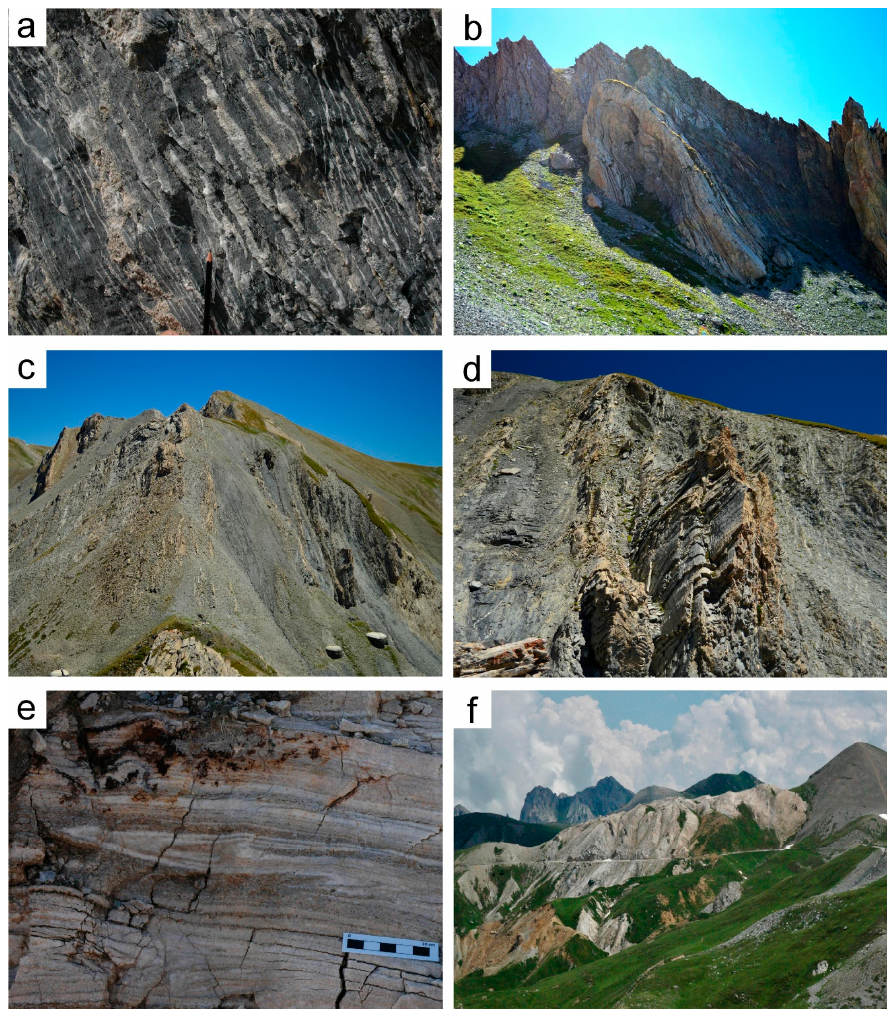
Figure 8. ( a ) Slickensided strike-slip fault surface bounding the GDZ on its southern side along the EBF (Dogger limestones of M. Bodoira); ( b ) steepened folds affecting the Jurassic-Cretaceous successions close to the EBF in the M. Bodoira tectonic unit; ( c ) subvertical, intensively sheared beds in the hundred-meters scale “Servagno transcurrent zone”. This zone is located on the GDZ southern boundary, along the EBF and it affects the Jurassic-Cretaceous succession of M.Bodoira near Servagno pass. ( d ) Detail of Figure10c, drag folds showing vertical axes and vertical axial planes developed along the individual strike-slip faults of the Servagno transcurrent zone; ( e )